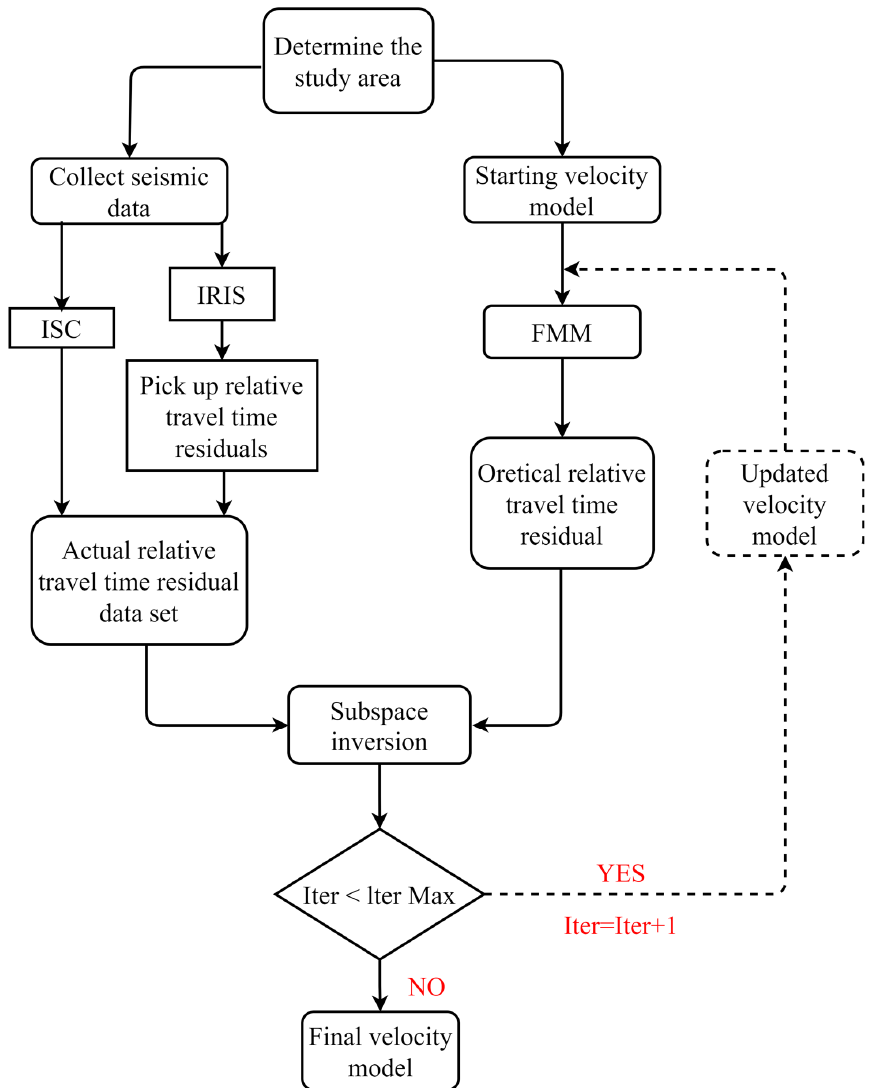
Figure 4. This flowchart describes the methodology of this study. We used the software package FMTT [30,31] to perform an iterative nonlinear tomo- graphic inversion of the subsurface P-wave velocity changes. The forward model was based on the Eikonal solver of the grid, namely, the fast marching method (FMM) algo- rithm, which is used to calculate the numerical value of the grid. It tracks the evolving interface along the narrow-band nodes and updates each grid node by solving the Eikonal equation using the finite difference approximation of the gradient vector satisfied by the upwind entropy. The main advantage is that it can generate reliable travel-time predic- tions in regions containing highly nonuniform velocity structures [32]. Our forward mod- eling was performed in parallel, which improves efficiency and facilitates travel-time pre- diction for large data sets. The inversion uses a subspace inversion scheme that adjusts the model velocity-node values to satisfy the data observations and travel-time residuals for damping and smoothing regularization constraints and eliminates non-uniqueness of the solution [33]. The subsurface structure is complex, and the velocity interface fluctuates greatly. Structure within the local 3D-model volume beneath the seismic array is repre- sented using smoothly varying cubic B-spline volume elements, the values of which are controlled by a mesh of velocity nodes in spherical coordinates.